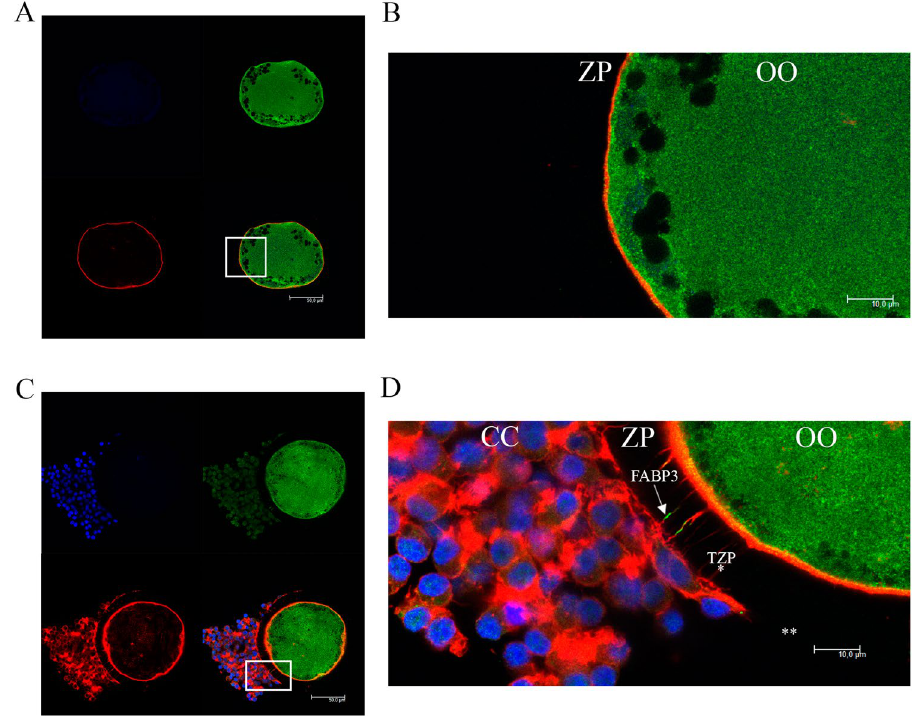
Figure 4. Confocal microscopic analysis of fatty acid binding protein 3 (FABP3) in tranzonal projections (TZPs) of denuded and partially denuded oocytes cultured in the maturation media for 9 h. ( A ) Images acquired from denuded oocytes show no FABP3 and TZPs within the zona pellucida. ( B ) The image of a portion of the denuded oocytes demonstrating the complete absence of TZPs and FABP3 within the zona pellucida. ( C ) Images acquired from a partially denuded oocyte demonstrating the presence of FABP3 at the same location as TZPs within the zona pellucida. ( D ) The portion of the partially denuded COCs demonstrating the complete absence of TZPs and FABP3 within the zona pellucida in the denuded area, and the presence of FABP3 and TZPs in the cumulus-enclosed area. FABP3 (arrow) is immunostained using 488 Alexa Fluor (green); TZPs (actin; asterisk) are stained with Alexa Fluor 647 phalloidin (red); nuclei are stained with DAPI (blue). Photomicrographs were obtained in 63x objective ( A and C ), and merged with z-stack captures with digital zoom ( B and D ) to illustrate the absence ( B ) or presence ( D ) of FABP3 along the TZPs. (OO = oocyte; CC = cumulus cells). ** indicates the lack of cumulus cells and TZPs. A total of 10 denuded oocytes and 11 partially denuded oocytes in vitro -matured for 9 hours were analysed and showed similar pattern; 6 additional denuded oocytes and 6 additional partially denuded oocytes are shown in Supplementary Figs S5 and S6,